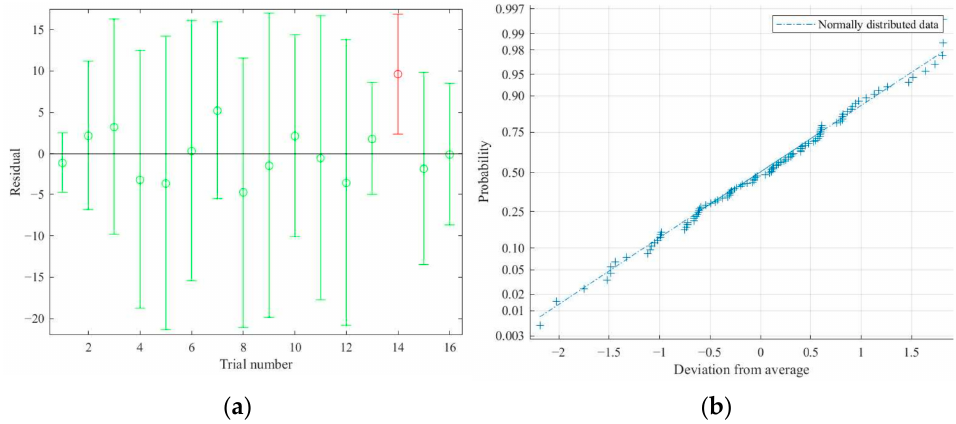
Figure 4. Residuals and normal probability plots of Equation (5): ( a ) residuals plots and ( b ) normal probability